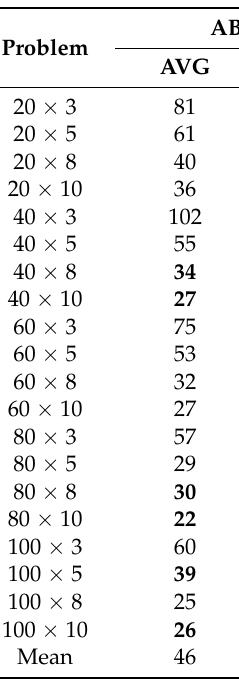
Table A4. N -metric for selection